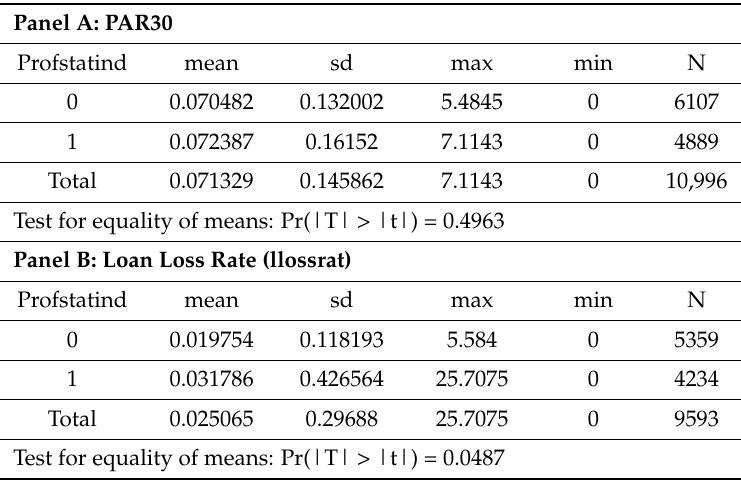
Table 2. Summary statistics for MFIs with differing profit status.